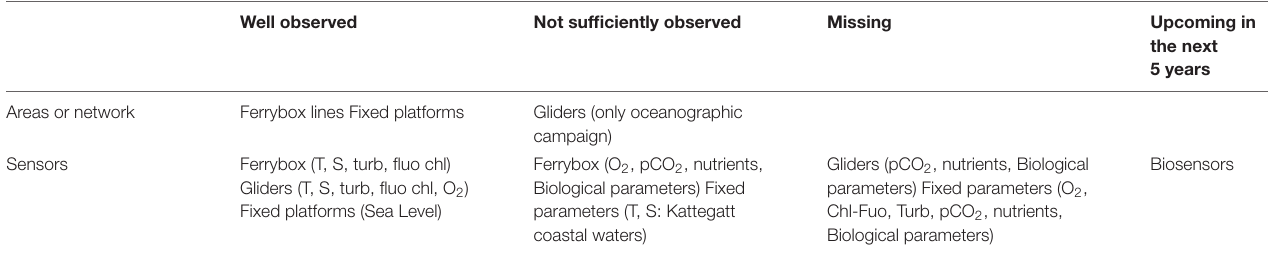
TABLE 1 | List of platforms and sensors currently deployed within the Baltic Ocean Observation System (taken from JERICO-FP7 D1.11 by Morin et al., 2015). Well observed Not sufficiently